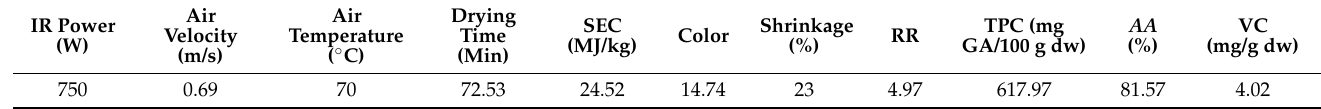
Table 13. The results of optimizing the process of drying pumpkin samples with CV/IR.